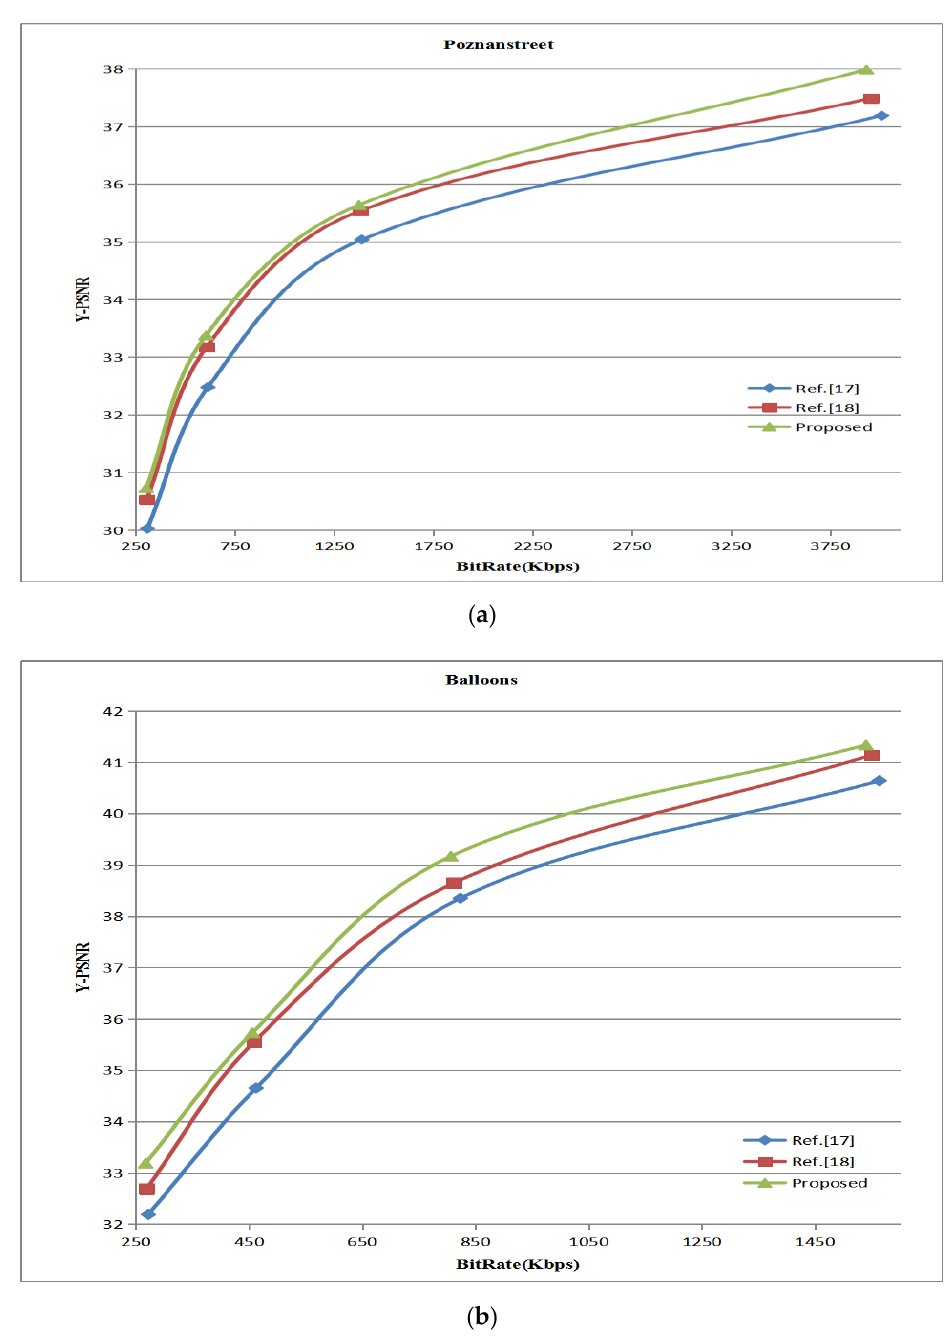
Figure 5. PSNR results. ( a ) Experimental results for the sequence “Poznanstreet”, and ( b ) Experimental results for the sequence “Balloons”.